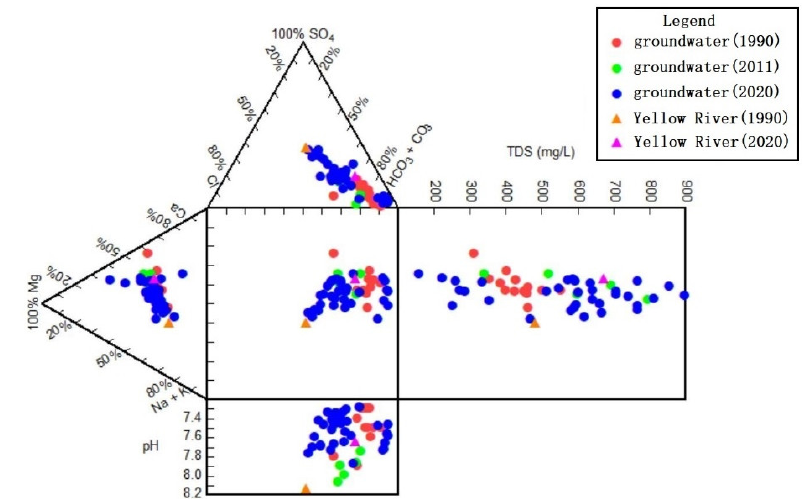
Figure 8. Durov map of groundwater in the study area.